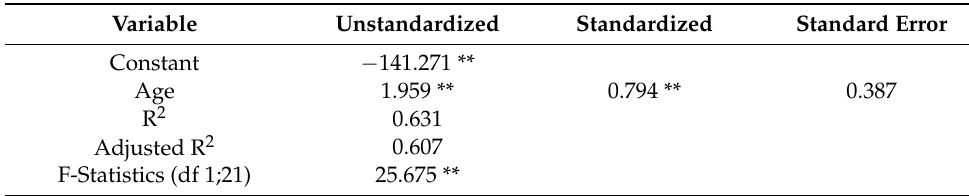
Table 8. Multiple regression analysis with OLSA 2 years after cochlear implantation in the elderly group as a dependent variable. ** p <